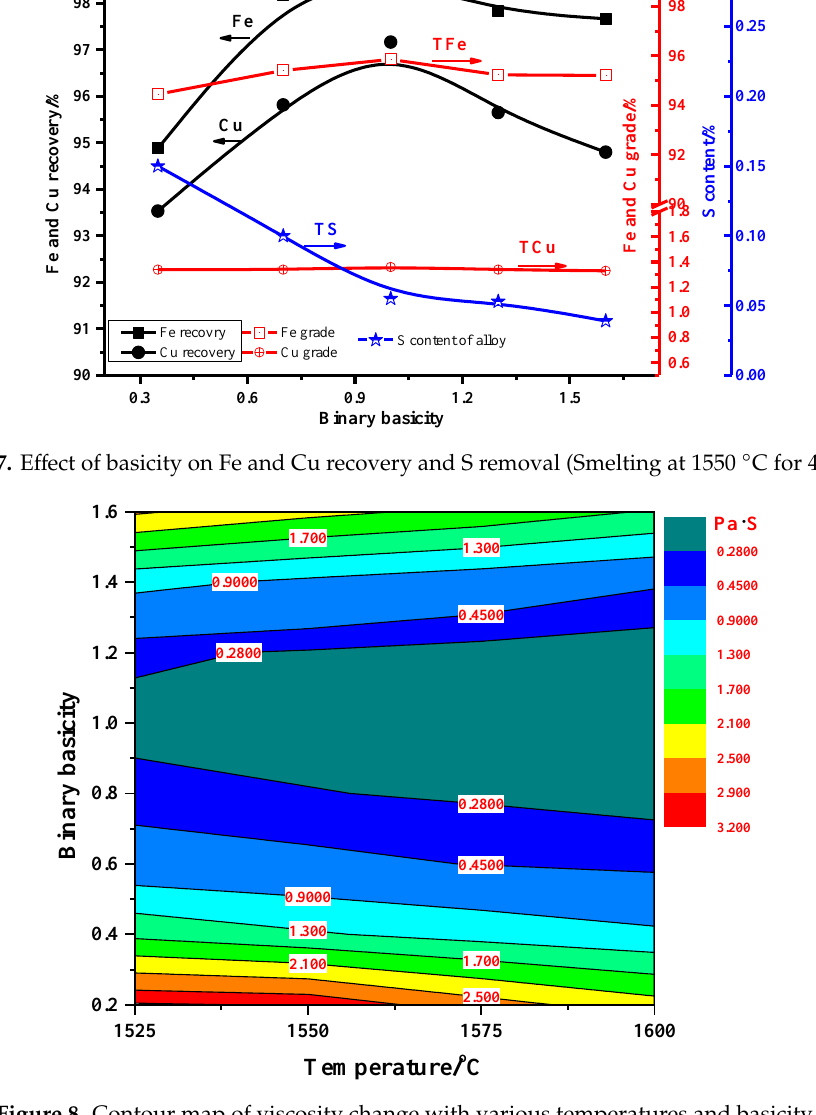
Figure 8. Contour map of viscosity change with various temperatures and basicity.